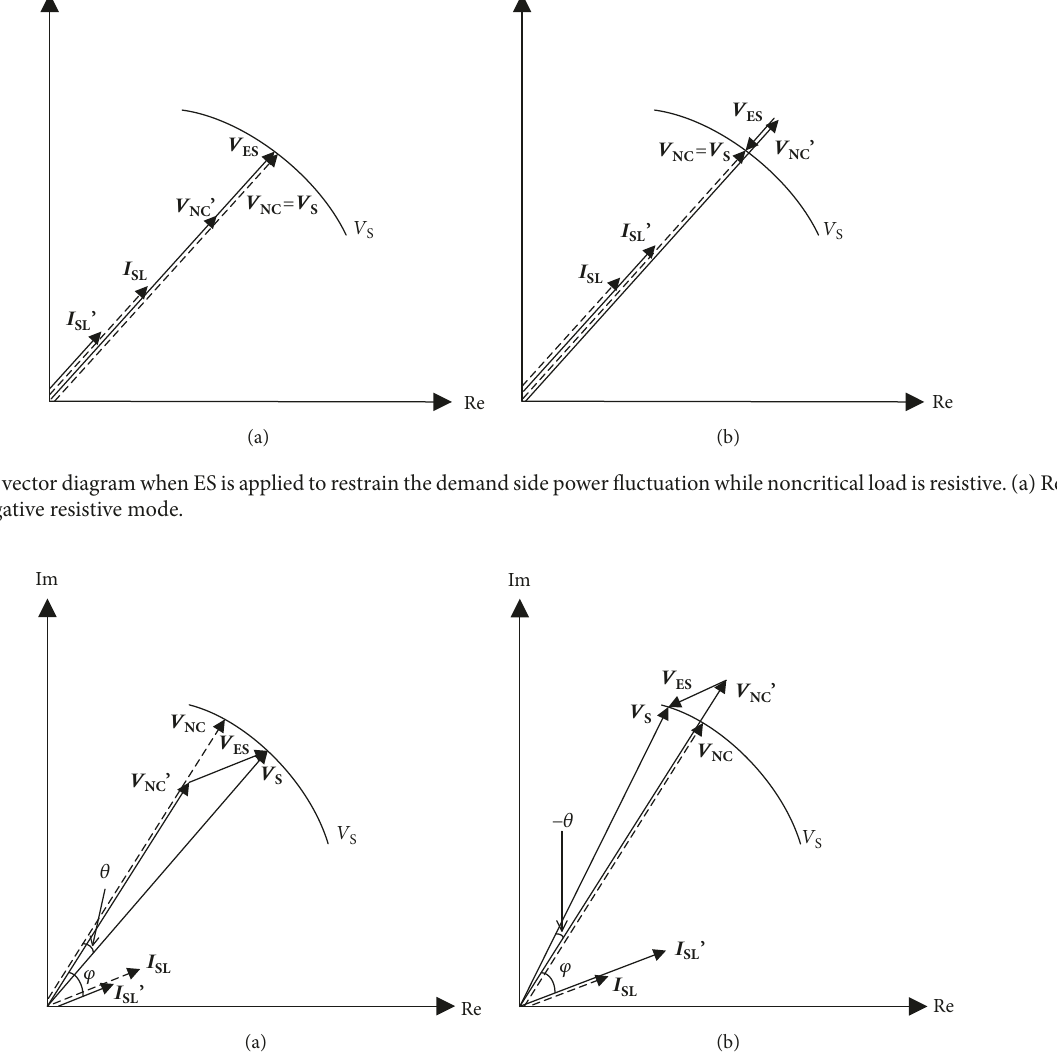
Figure 5: The vector diagram when ES is applied to restrain the demand side power fluctuation while noncritical load is resistive-inductive. (a) Resistive mode. (b) Negative resistive